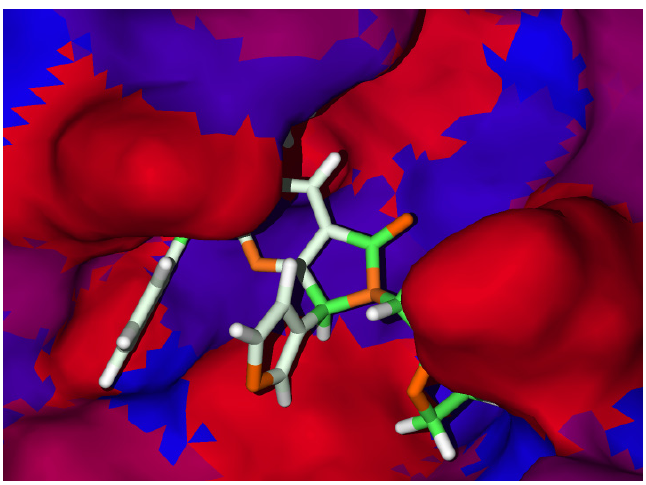
Figure 4. Hydrophobicity surfaces for 8c . Red and blue surfaces represent the hydrophilic and hy- drophobic surfaces of the SARS-CoV-2-M Pro , respectively. Green and orange sticks are the hydrophilic and hydrophobic moieties of 8c .